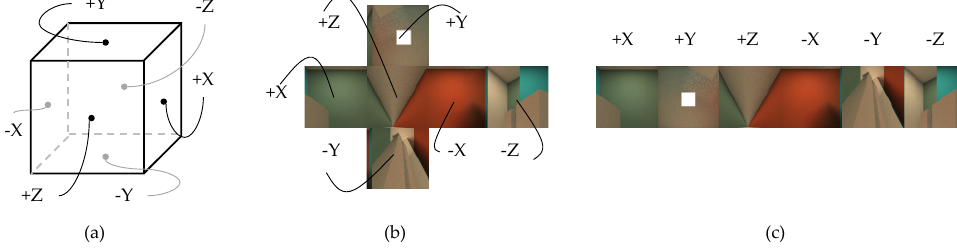
Figure 3. The different layouts of cube map. ( a ) six face are marked by +X to − Z, ( b ) the cross layout and ( c ) the horizontal